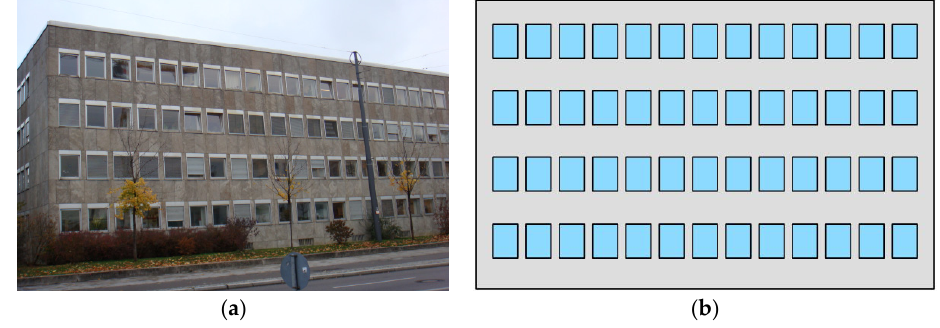
Figure 1. An example façade and its vector representation: ( a ) Example façade of the building located in Arnulfstrasse 53, Munich; ( b ) Windows extracted from the image.